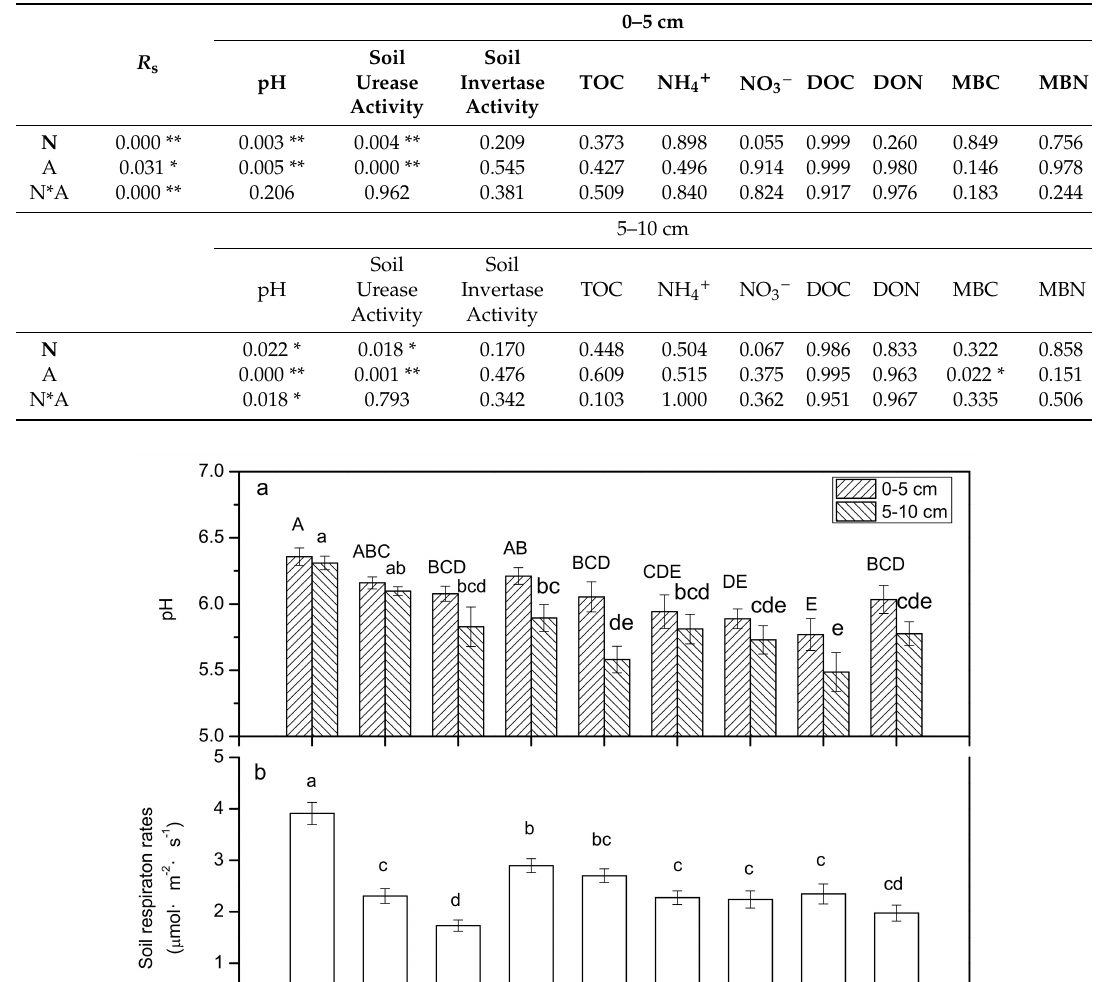
Table 2. Main e ff ects and interactive e ff ects of N addition and acid addition on soil respiration rate and soil properties via a two-factor ANOVA. N: N addition; A: acid additions; N*A: N addition plus acid addition; data are shown at significance levels. * and ** indicate significant di ff erences at 0.05 ( p < 0.05) and 0.01 significance levels ( p < 0.01), respectively. R s , TOC, DOC, DON, MBC and MBN Respectively